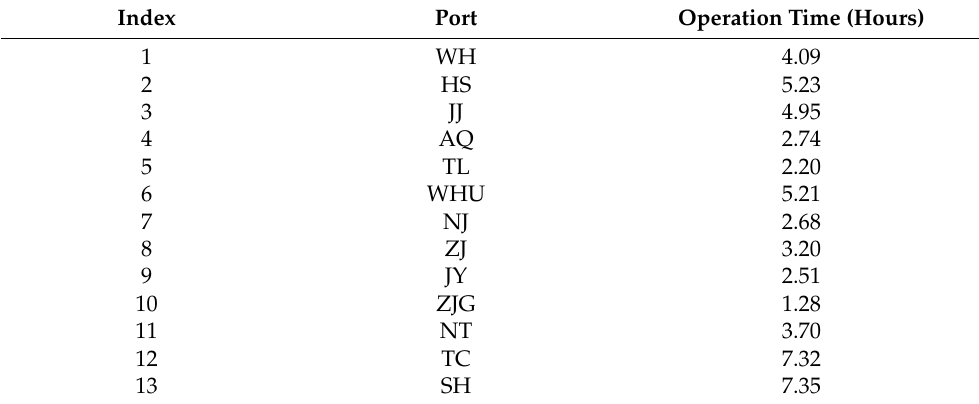
Table 5. Port operation time.